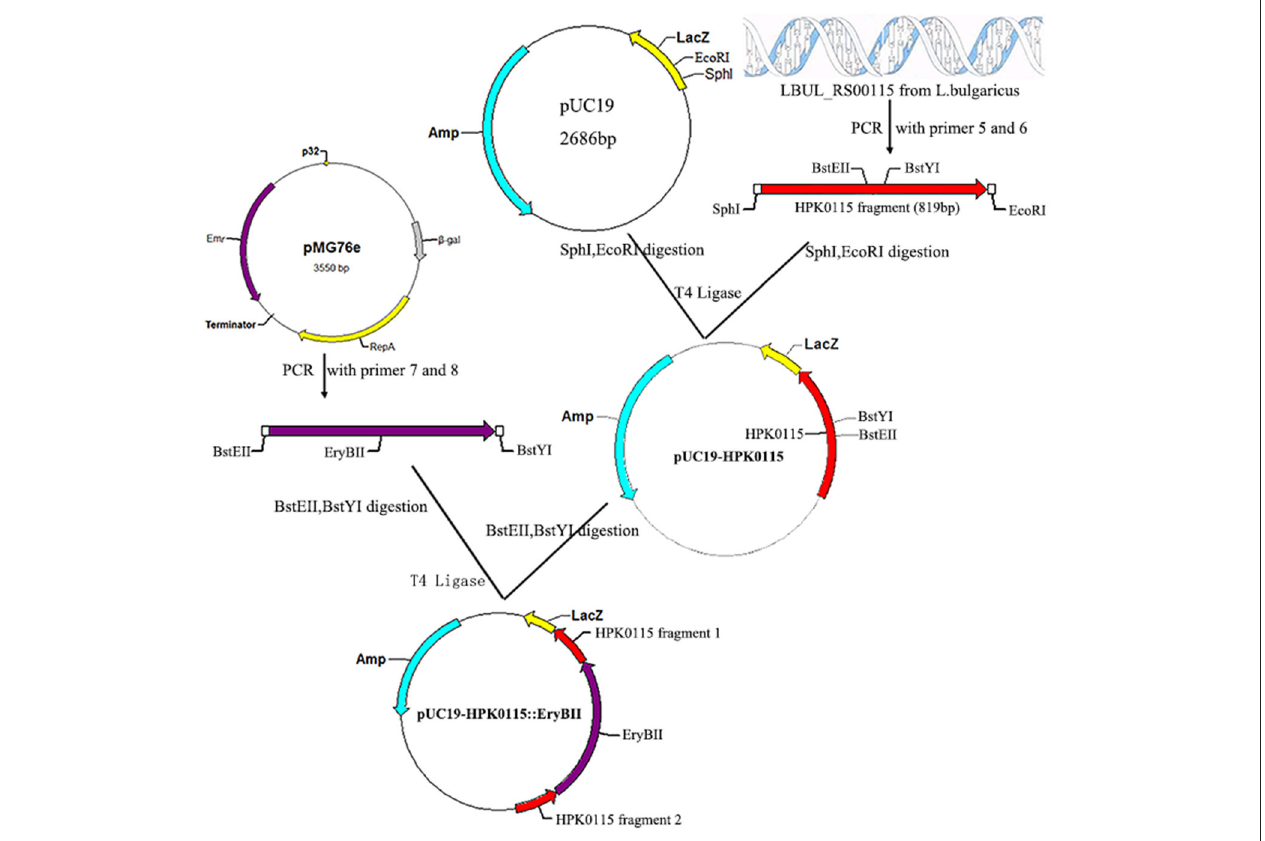
FIGURE 2 | Construction of recombinant plasmid pUC19-HPK0115::EryBII. The red arrow represents the HPK0115 gene fragment from L. bulgaricus ATCC BAA-365; The cyan arrow represents the ampicillin resistance gene; The purple arrow represents the erythromycin resistance gene; SphI, EcorI, BstEII, BstYI are four endonuclease hydrolysis